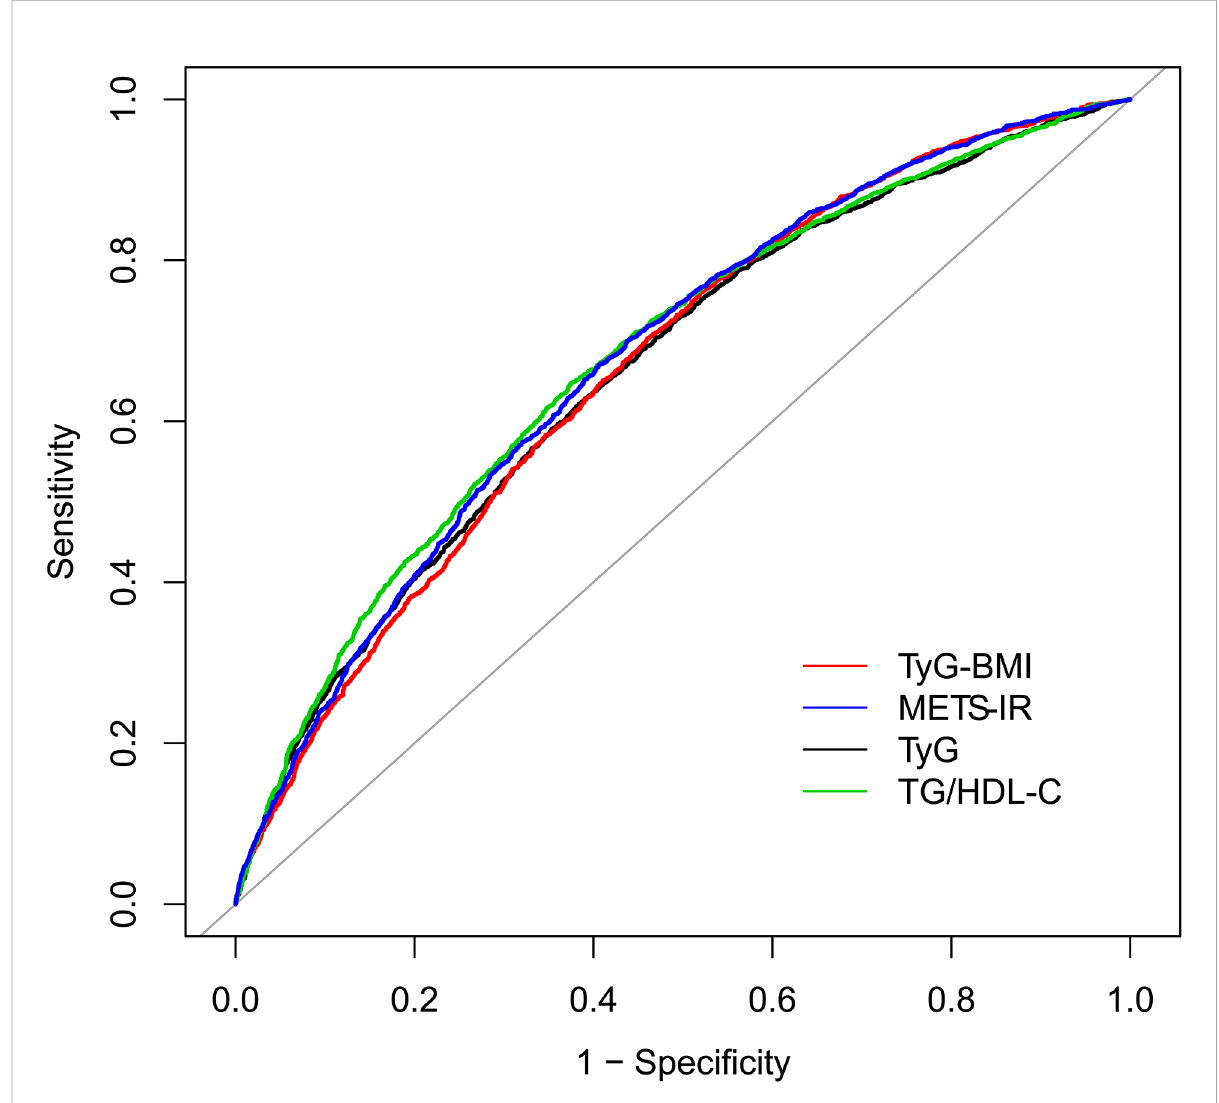
FIGURE 2 ROC for different IR surrogates to predict HU. HU, hyperuricemia; TyG, triglyceride glucose; TyG-BMI, triglyceride glucose with body mass index; TG/HDL-C, the ratio of triglycerides divided by high-density lipoprotein cholesterol; METS-IR, metabolic score for insulin